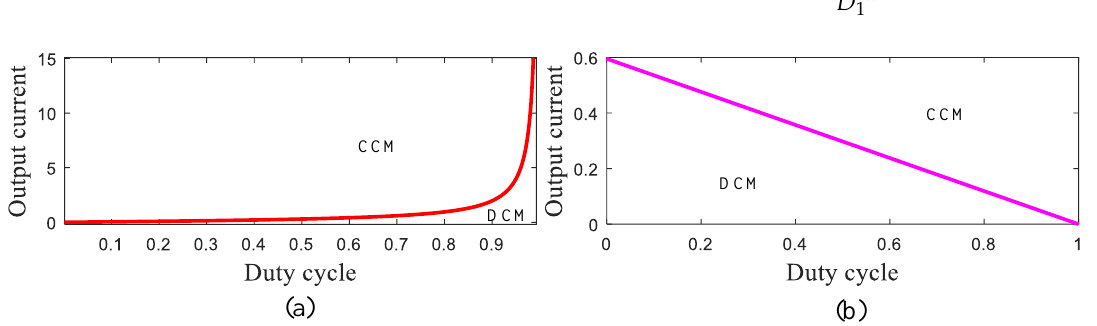
Figure 3. Operational region of the converter in CCM and DCM, while the frequency is 100 kHz, the last inductor is 1500 µ H , and ( a ) the output voltage is constant (90 V), ( b ) the input voltage is constant (30